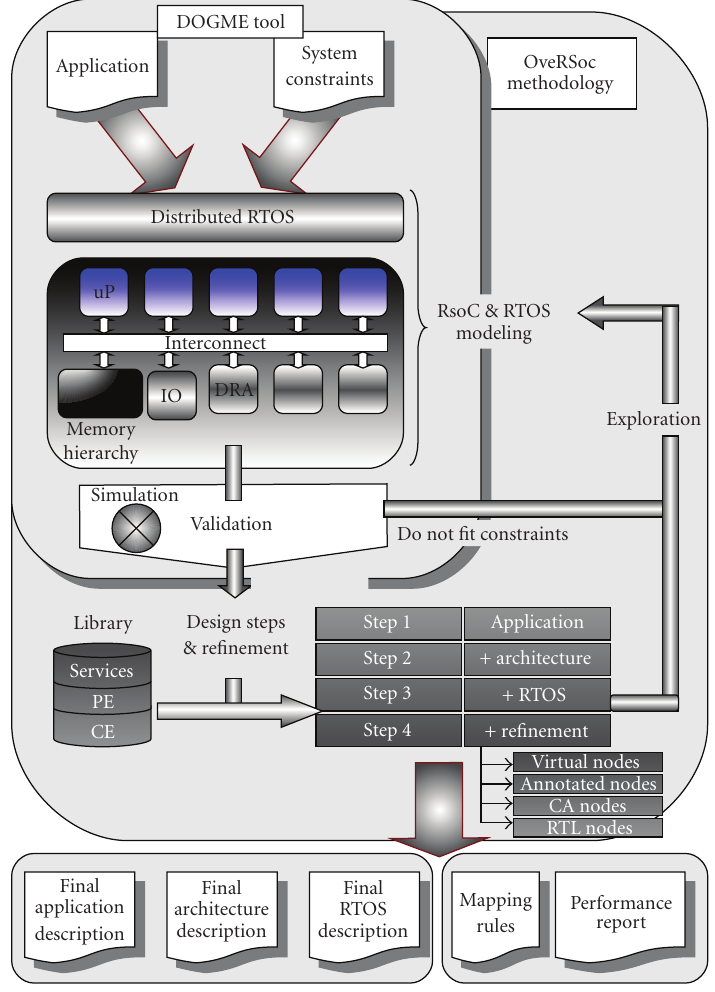
Figure 1: The OveRSoC exploration and refinement flow. Exploration is defined as an iterative process: modeling, simulation/validation and exploration. The inputs of the method are the specification of the application as a pure functional C code, and the system constraints. Once the system validated, the design process starts again at a lower level of abstraction until the final system description. At each level of abstraction, the goal of the exploration depends on the separation of concerns paradigm (Section 3.2). This paradigm is defined as a 4 steps process where the following concerns are successively addressed: application specification, architecture description, RTOS definition and platform